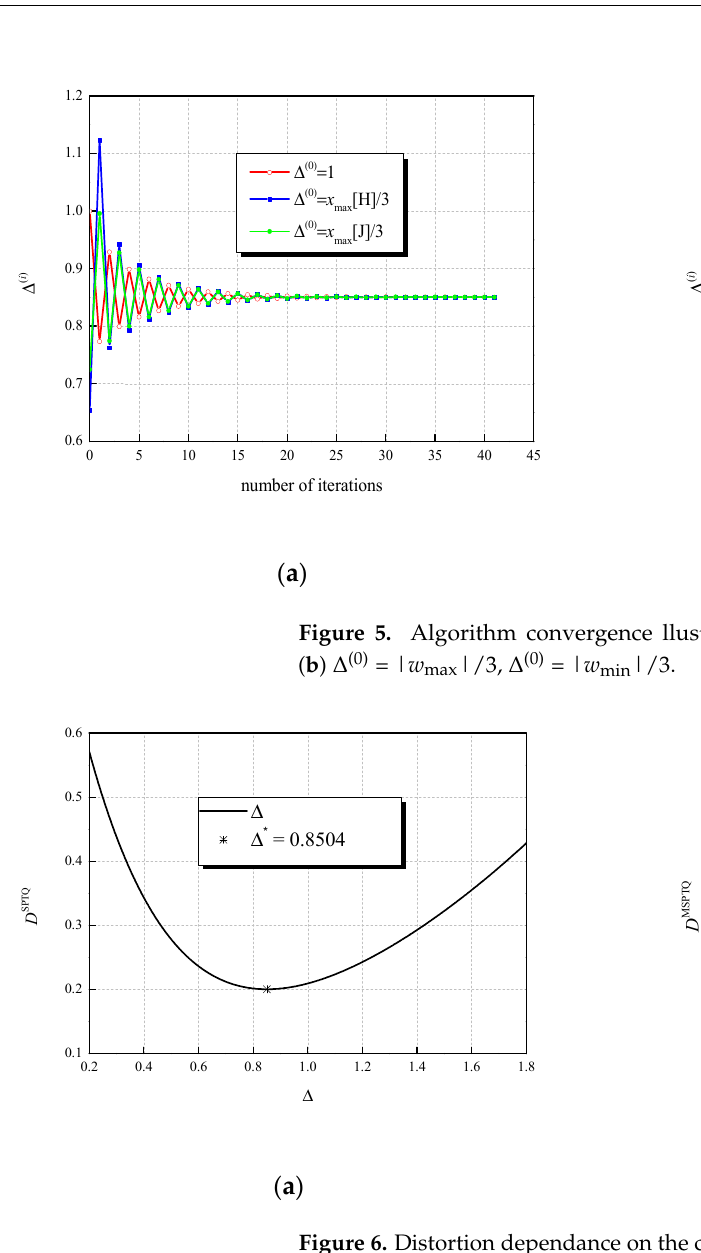
Table 2. Number of iterations for determining x maxSPTQ for different initializations.